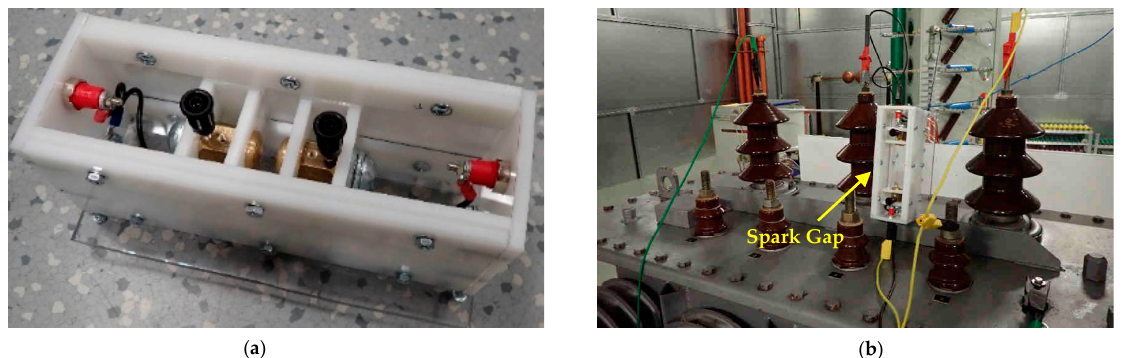
Figure 2. ( a ) Adjustable spark gap with a brass electrode and ( b ) connection of the spark gap to the middle terminal.